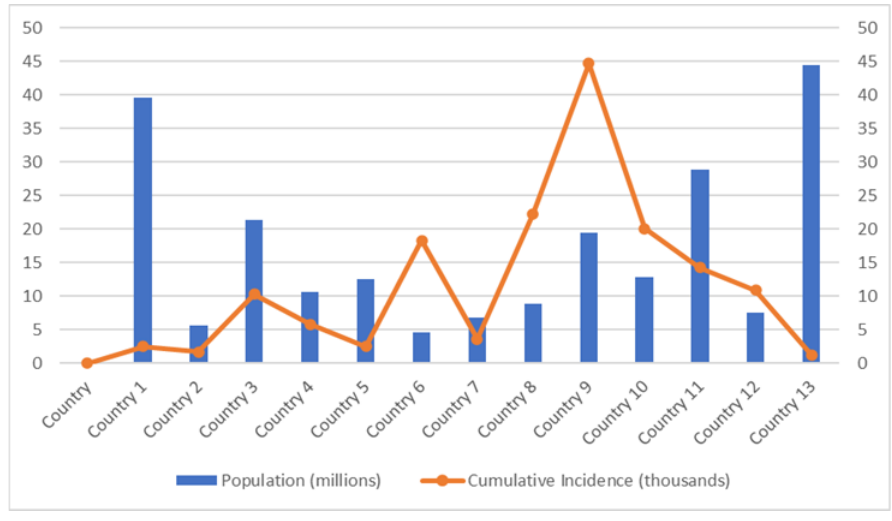
Figure 1. Cumulative COVID-19 cases in different populations.